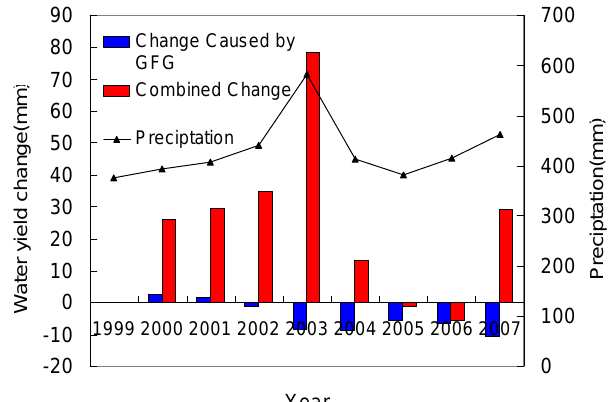
Fig. 7. Temporal variability of change in water yield due to land Fig. 7 Temporal variability of change in water yield due to land cover change only and cover change only and combined climate and land cover change combined climate and land cover change during 2000-2007 during